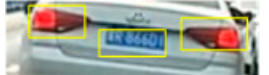
Figure 9. The taillight candidate areas extracted by the gradient feature.